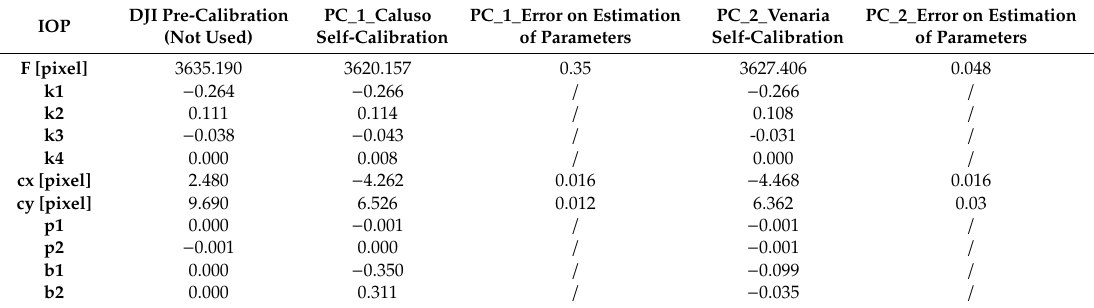
Table 7. IOP of the Phantom RTK embedded camera (Agisoft Metashape was used for the self-calibration). Values represented by “ / ” are